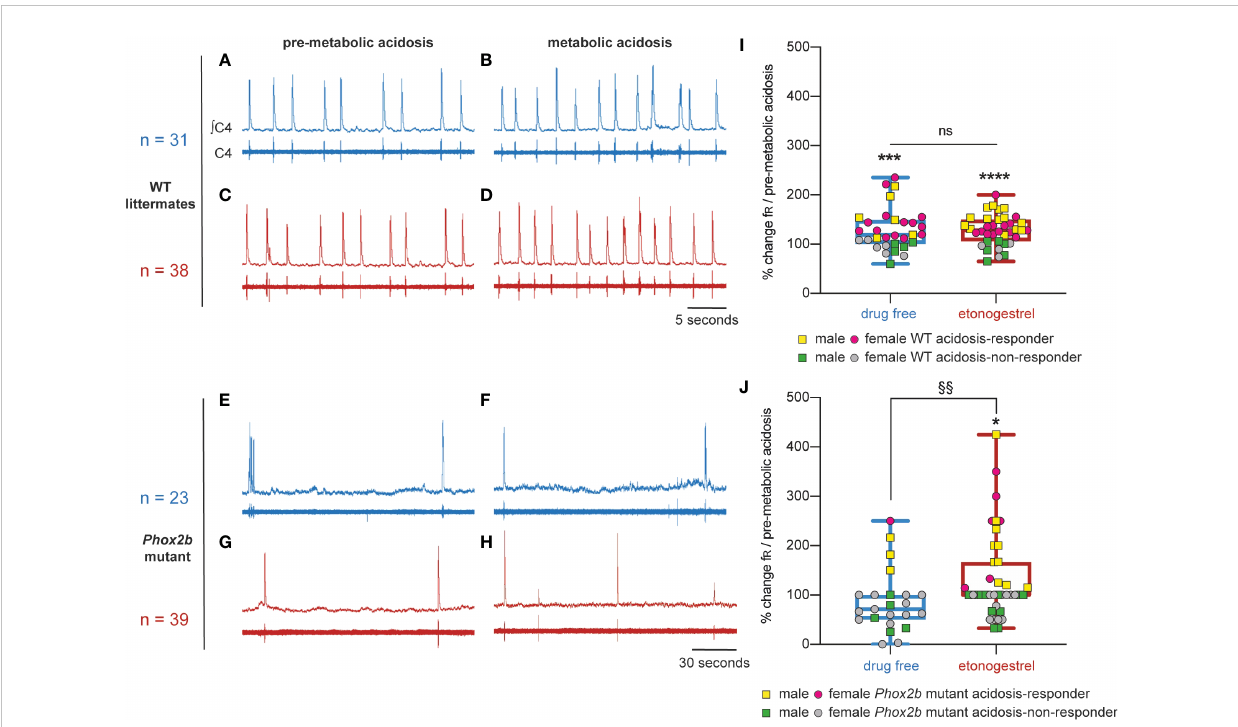
FIGURE 3 Effects of etonogestrel on central H + chemosensitivity in Phox2b mutant mice. (A – H) , Individual phrenic activity traces (fourth cervical ventral nerve root, C4) and integrated C4 activity from medullary-spinal cord from wildtype littermates (A – D) and Phox2b mutant mice (E – H) preparations, under drug-free (A, B, E, F) or etonogestrel ( C, D, G, H; 5.10 -2 µM) exposure, in normal-pH ( A, C, E, G ; pre-metabolic acidosis) or metabolic acidosis conditions (B, D, F, H) . (I, J), Scatter plots with a superimposed box and whisker (median [Q1; Q3] and minimum and maximum values) showing the respiratory-like rhythm (respiratory frequency, fR) during the last fi ve minutes of metabolic acidosis in percentage of pre-metabolic acidosis values under drug-free and etonogestrel exposure in wildtype littermates ( I ; n=31 and n=38 respectively) and Phox2b mutant mice ( J ; n=23 and